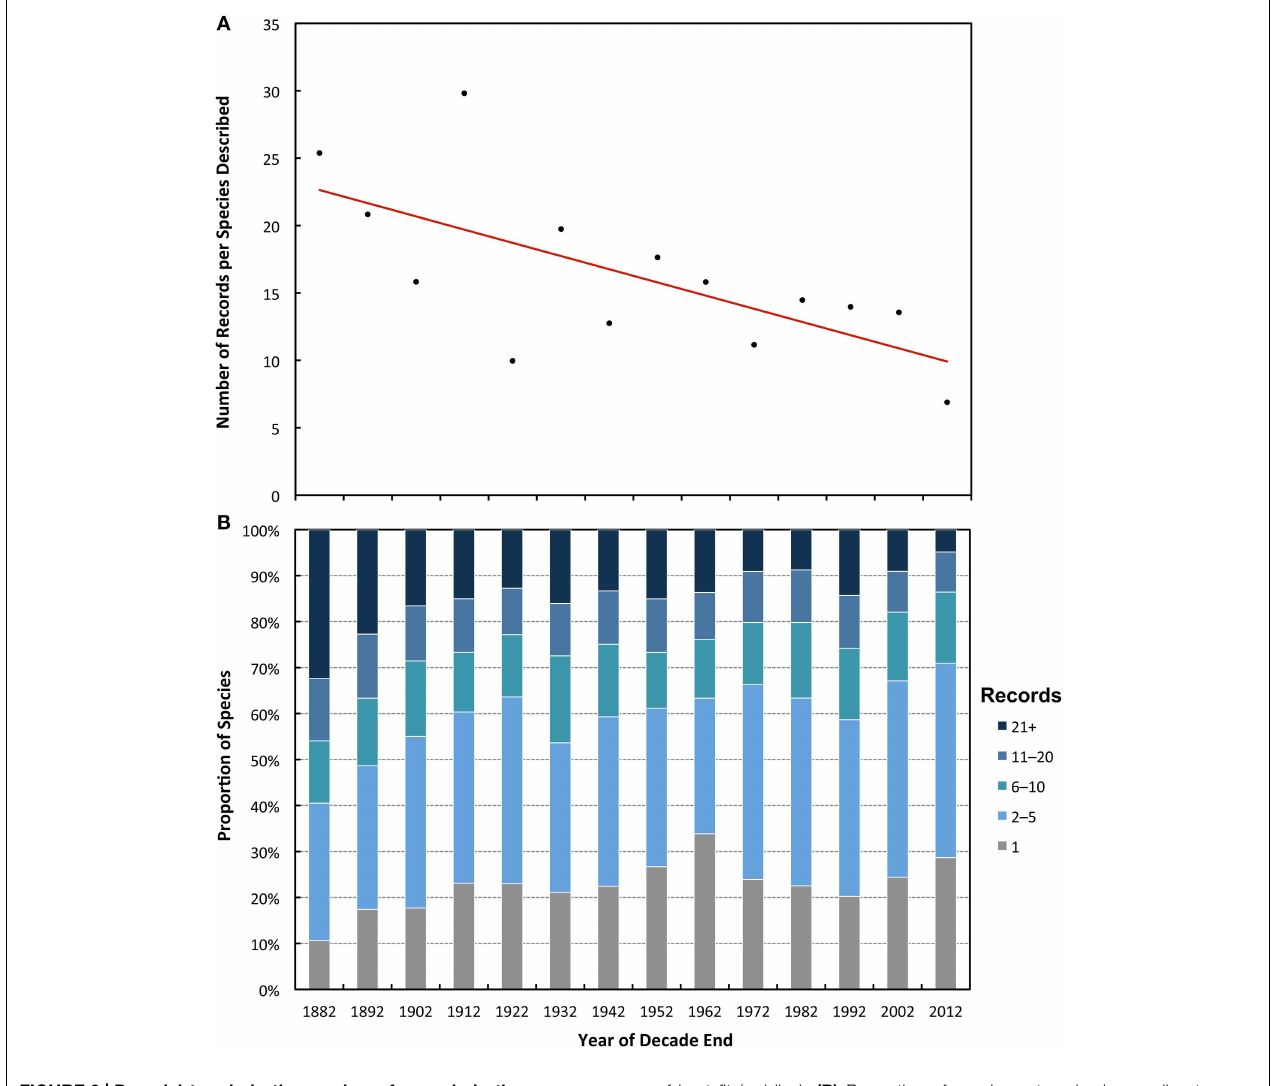
FIGURE 2 | Decadal trends in the number of records in the database, including species with only one record. (A) Number of records in the database for species described in each decade, with line